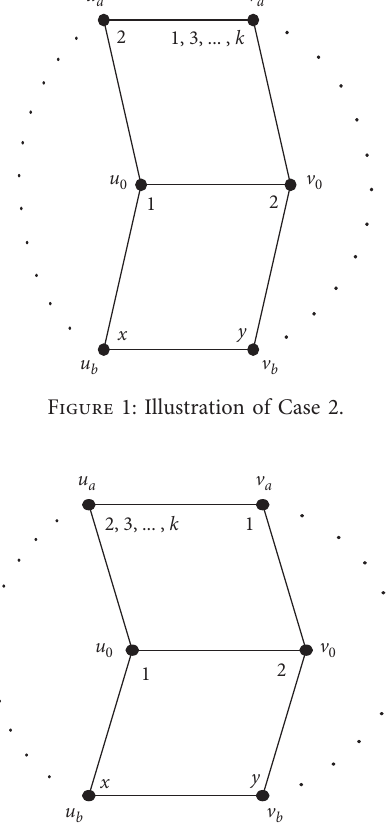
Figure 2: Illustration of Case